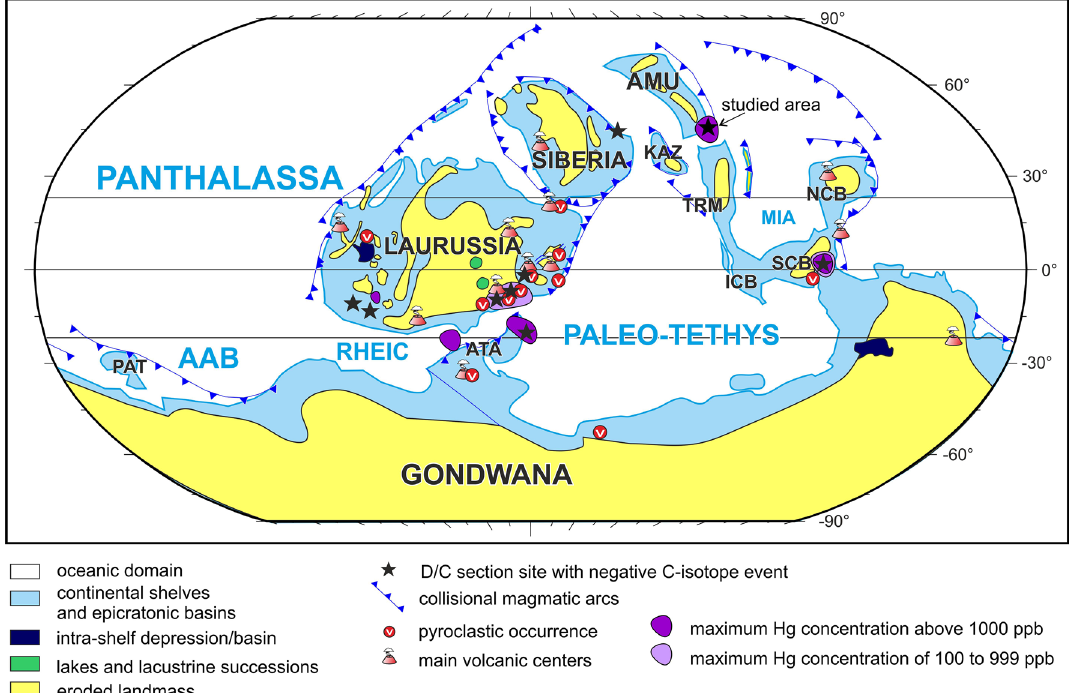
Figure 7. Distribution map of the latest Famennian magmatic activity centers, and the location of pyroclastic and mercury-enriched deposits. Palaeogeographic map modified after [Fig. 14 in 6 : https ://doi.org/10.1016/j. glopl acha.2020.10315 5; see also 96 ). Hg concentrations based on this study and after 6,97 . The most likely candidate for the observed Hg anomalous contents is arc magmatism. AAB Arequipa–Antofalla Ocean, AMU Amuria, ATA Armorican Terrane Assemblage, ICB Indochina, KAZ Kazakhstan, MIA Mianlue Ocean, NCB North China, PAT Patagonia, SCB South China, TRM